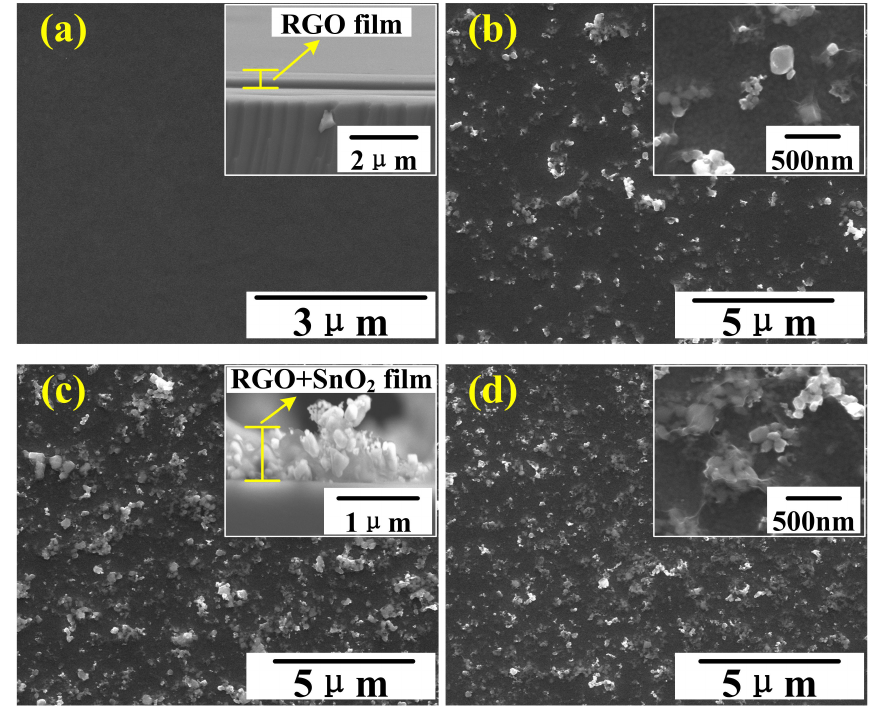
Figure 2. ( a – d ) SEM images of RGO, 9.7%RGO/SnO 2 , 5.1%RGO/SnO 2 and 2.6%RGO/SnO 2 film. The inset figures in ( a , c ) are cross-section images. The inset figures in ( b , d ) are magnification images.